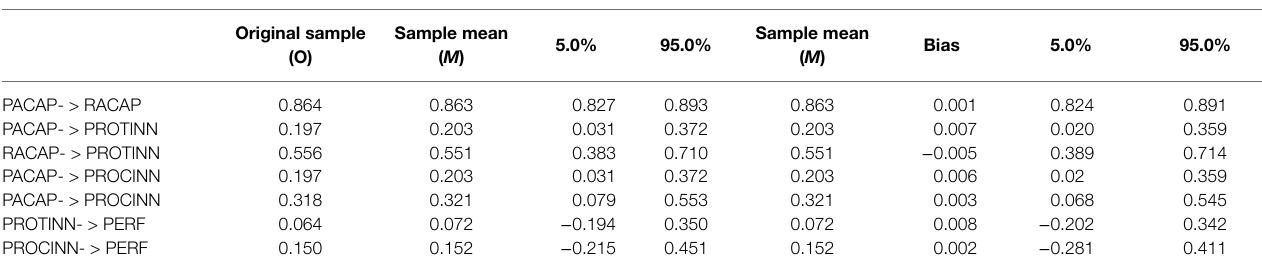
TABLE 5 | HTMT inference.